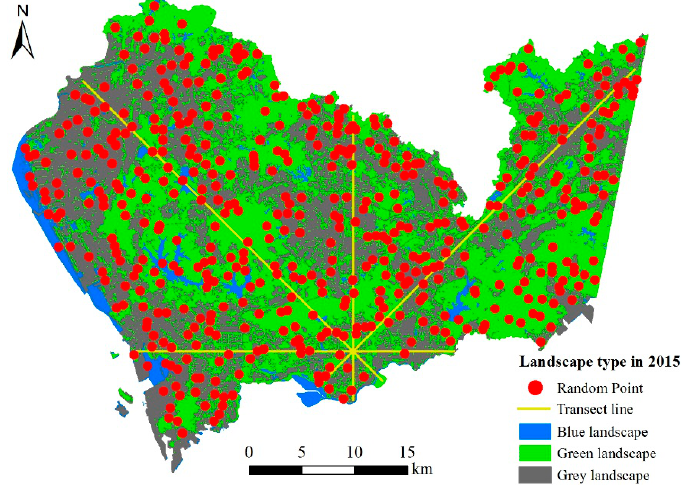
Figure 3. Randomly selected validation points for landscape type interpretation, and transect line locations for detecting landscape and LST changes.